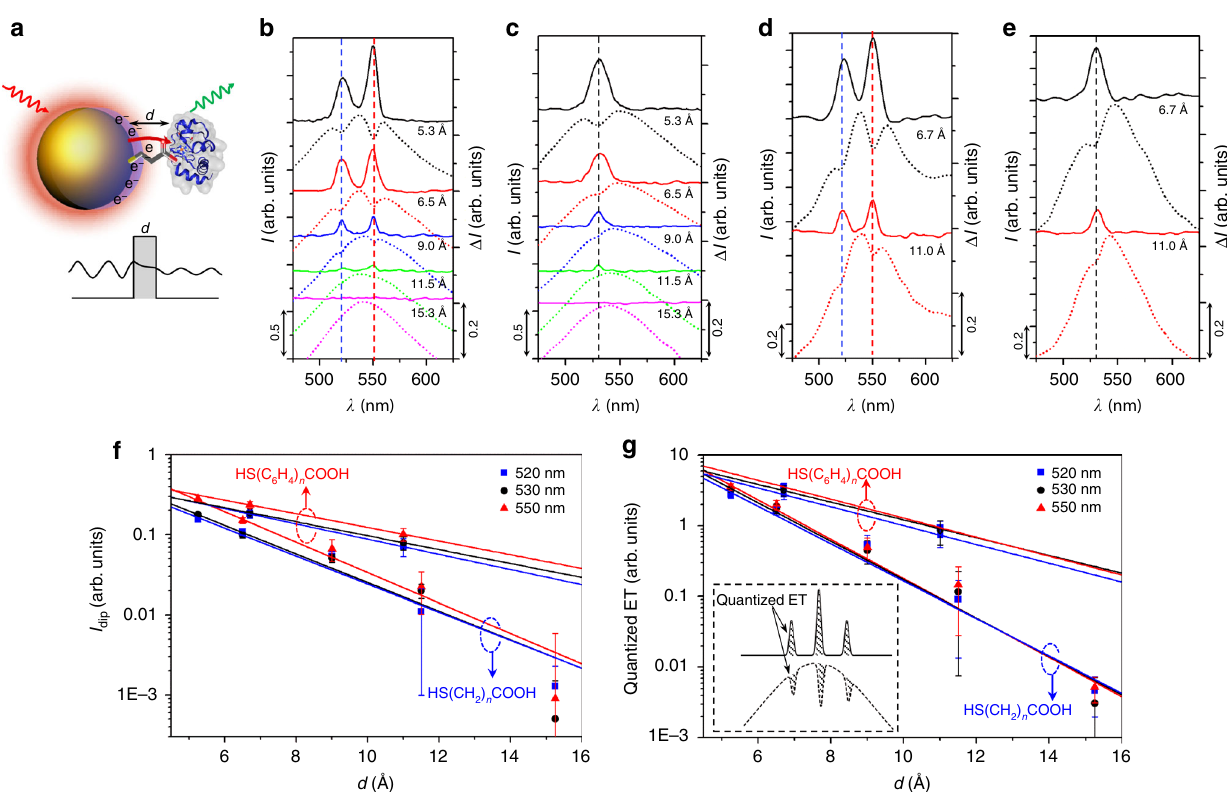
Fig. 2 Tunnelling behaviour with different barrier width. a Schematic of electron tunnelling in A/B/C tunnel junction with variable barrier width d . The cartoon for Cyt c molecule was created from the RSCB protein data bank 54 . b – e Scattering spectra and spectra difference for QBET imaging in ( b , d ) A/B/ C (Red.) and ( c , e ) A/B/C (Ox.) tunnel junction with ( a , b ) HS(CH 2 ) n COOH and ( c , d ) HS(C 6 H 4 ) n COOH of different barrier widths as linker molecules. The quantised peaks were obtained from the difference of scattering spectra between the GNP-Cyt c conjugation and the linker molecule modi fi ed GNP without Cyt c . Dashed curves are captured scattering spectra (linked to left axis) of GNP-Cyt c conjugation, and solid curves are the corresponding spectra difference (linked to right axis). Blue and red dashed lines in b , d indicate the quantised dips (peaks) at 520 and 550 nm, respectively, while the black dashed lines in c , e indicate the dips (peaks) at 530 nm. f Dip depth ( I dip ) as a function of barrier width with exponential fi tting. The red dashed circle with an upwards arrow and blue dashed circle with a downwards arrow indicate the two groups of data are for HS(C 6 H 4 ) n COOH and HS(CH 2 ) n COOH, respectively. g Quantised ET as a function of barrier width, experimental data are fi tted using the quantum tunnelling equation. Inset shows the schematic of accumulated quantised ET from the integral of the dips in the scattering spectra. Error bars represent standard